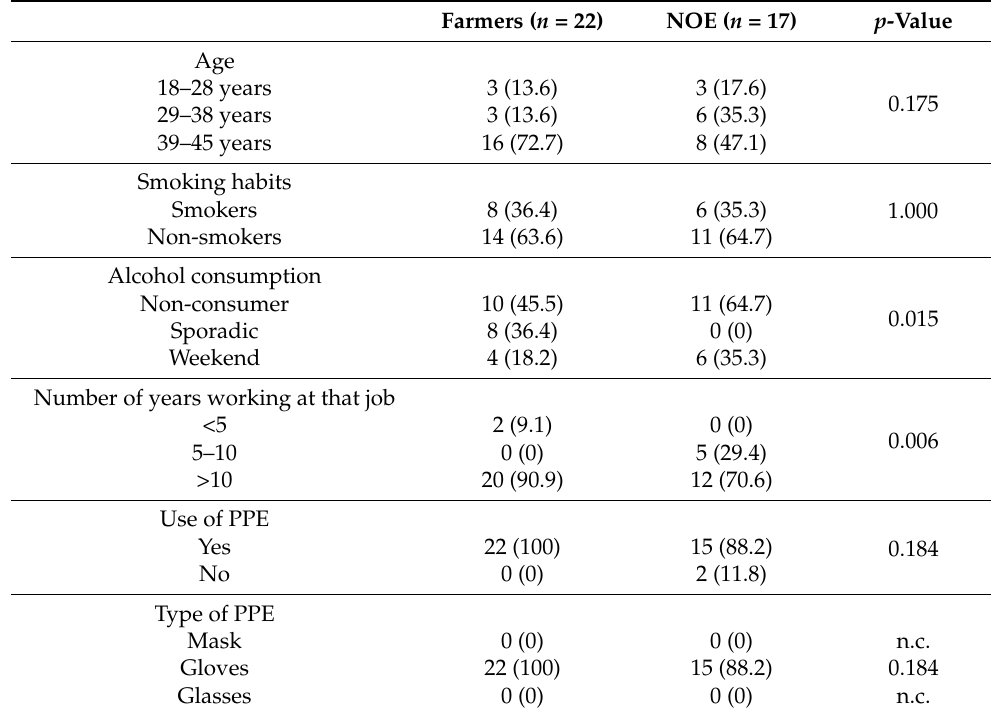
Table 2. General characteristics of farmers and non-occupational exposed (NOE) groups. n.c.: not calculable; PPE: personal protective equipment. Data are expressed as number of patients [ n , (%)]. Farmers ( n = 22) NOE ( n =